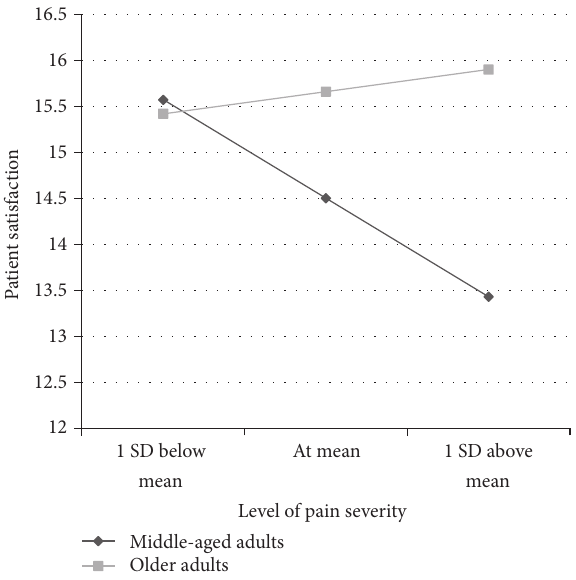
Figure 1: Estimated means of patient satisfaction with pain manage- ment by age group at different levels of pain